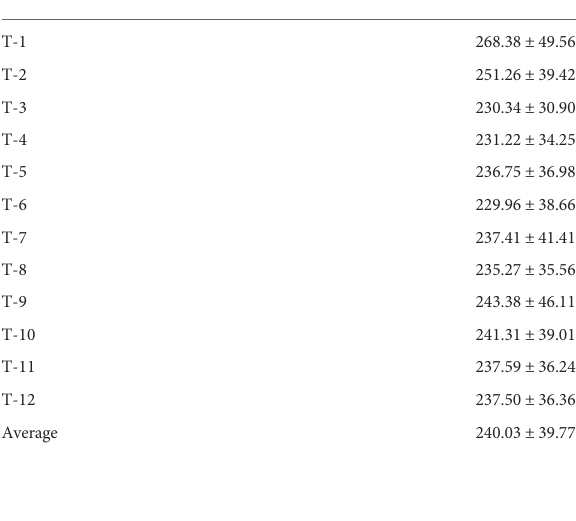
TABLE 2 Hu value in controls.